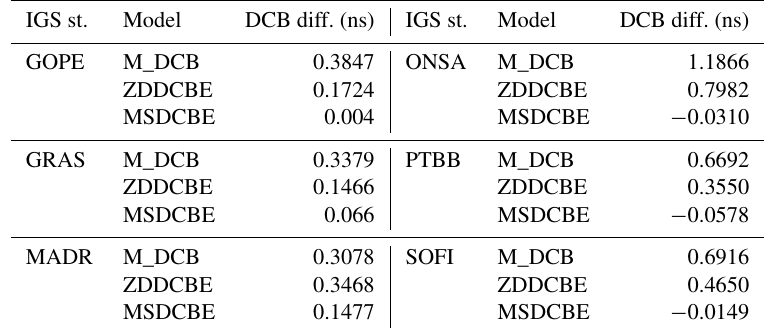
Table 2. Mean difference between the receiver DCB values computed by the IGS and the computed values by using single-station M_DCB, ZDDCBE, and multi-station MSDCBE estimated from 1 to 5 January 2010. IGS